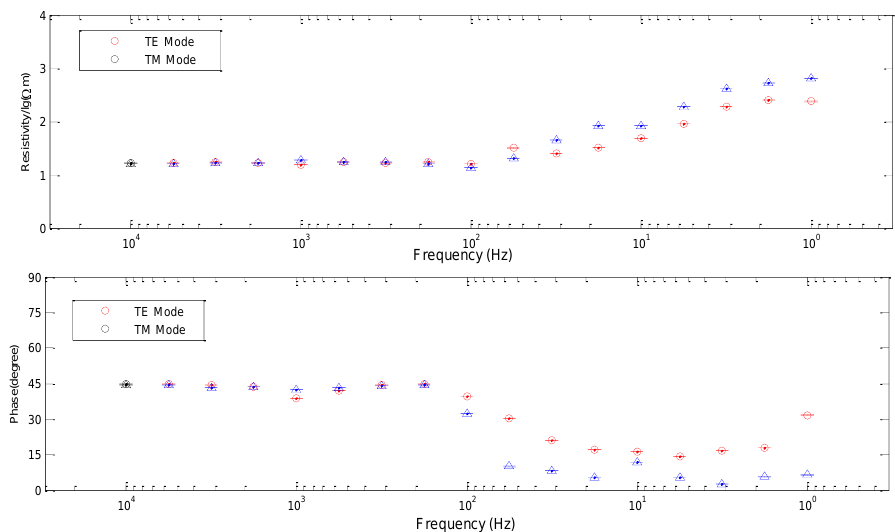
Figure 9. The processing results of collected data in one site in the water-rich coal mining goaf area. The red curve indicates the TE mode and the blue curve indicates the TM mode.